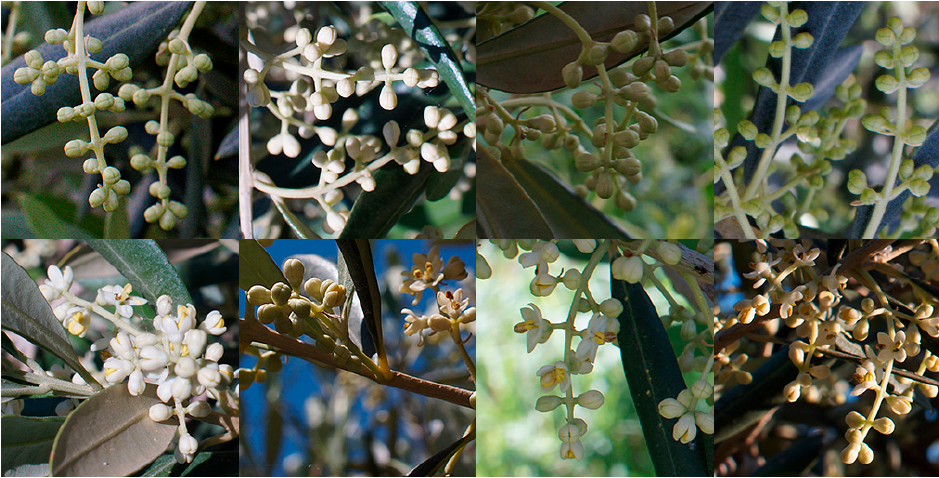
Figure 2. Details of canopies during various phenological stages (upper row—class 0, lower row—class 1).